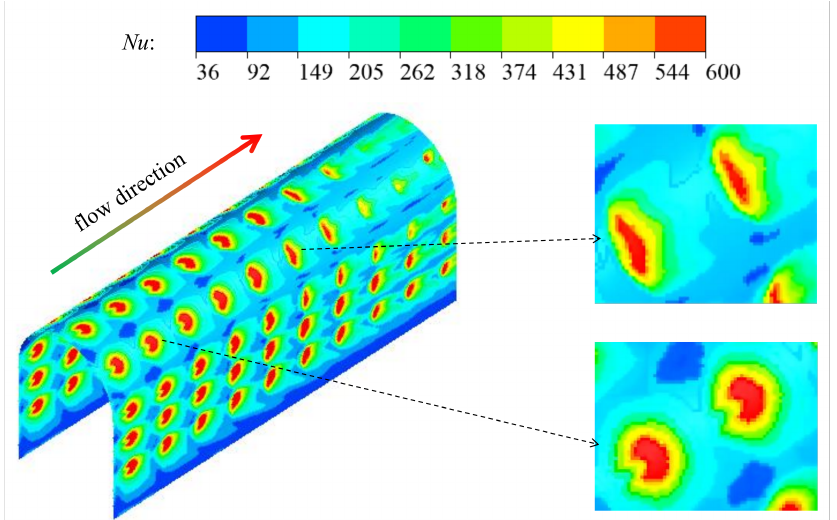
Figure 6. Heat transfer distribution characteristics of steam jet array impingement cooling in the quasi-leading-edge channel.